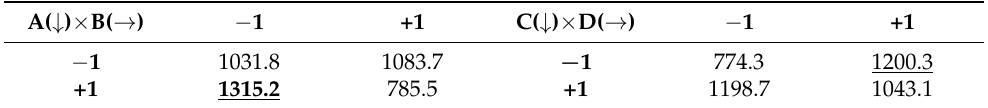
Table 9. Effect of the interactions AB and CD in the analysis of fracture strength at failure in a 3-point bend